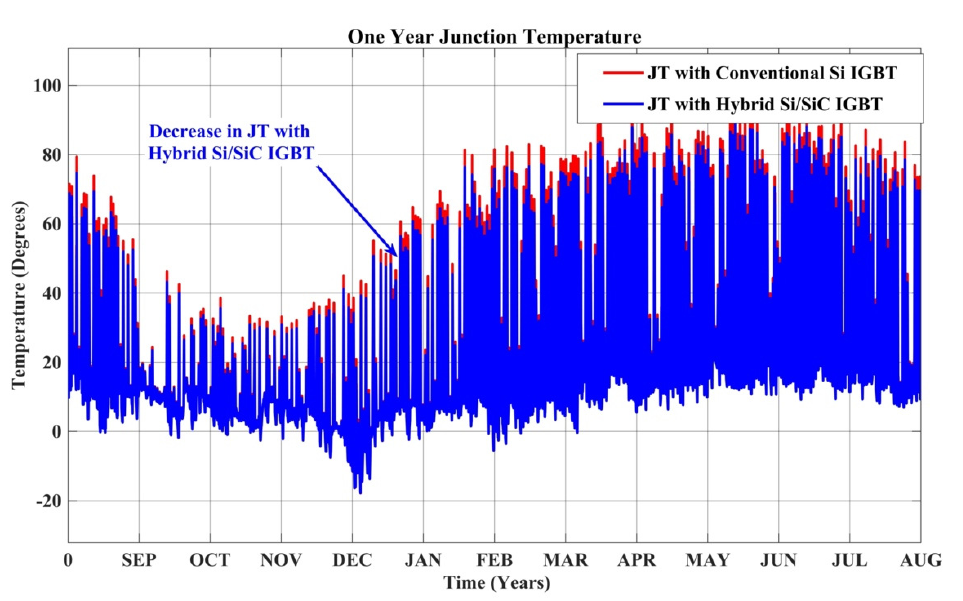
Figure 11. Yearly T j in Denmark.